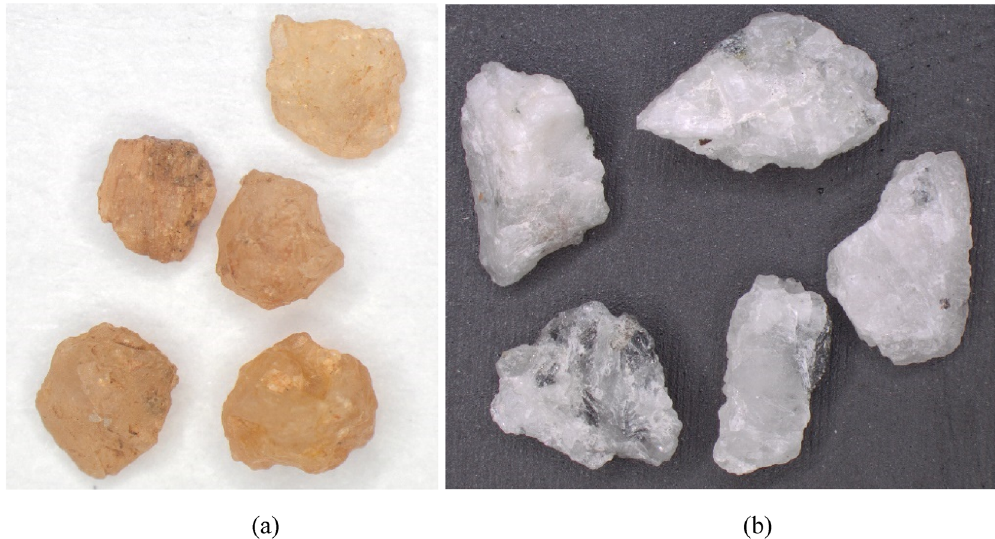
Figure 4. Microscopic images of typical sand particles at 25× magnification ( a ) river sand and ( b ) manufactured sand.